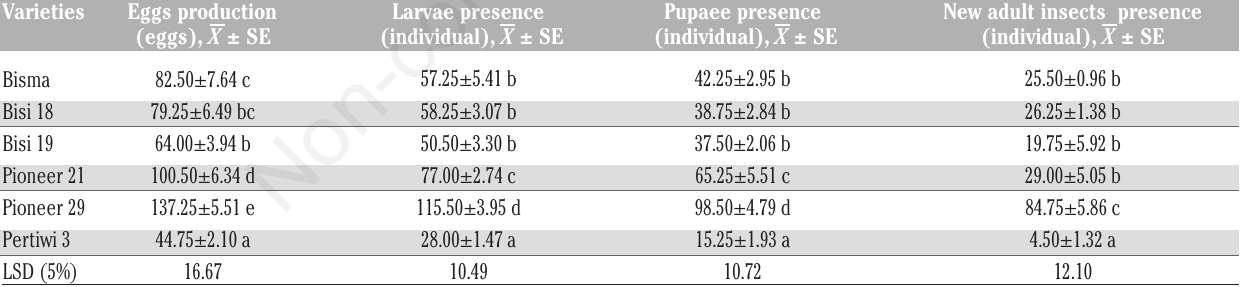
Table 3. Mean value of eggs, larvae, pupaee, and new emerging S. zeamais Imago in six corn varieties. Varieties Eggs production